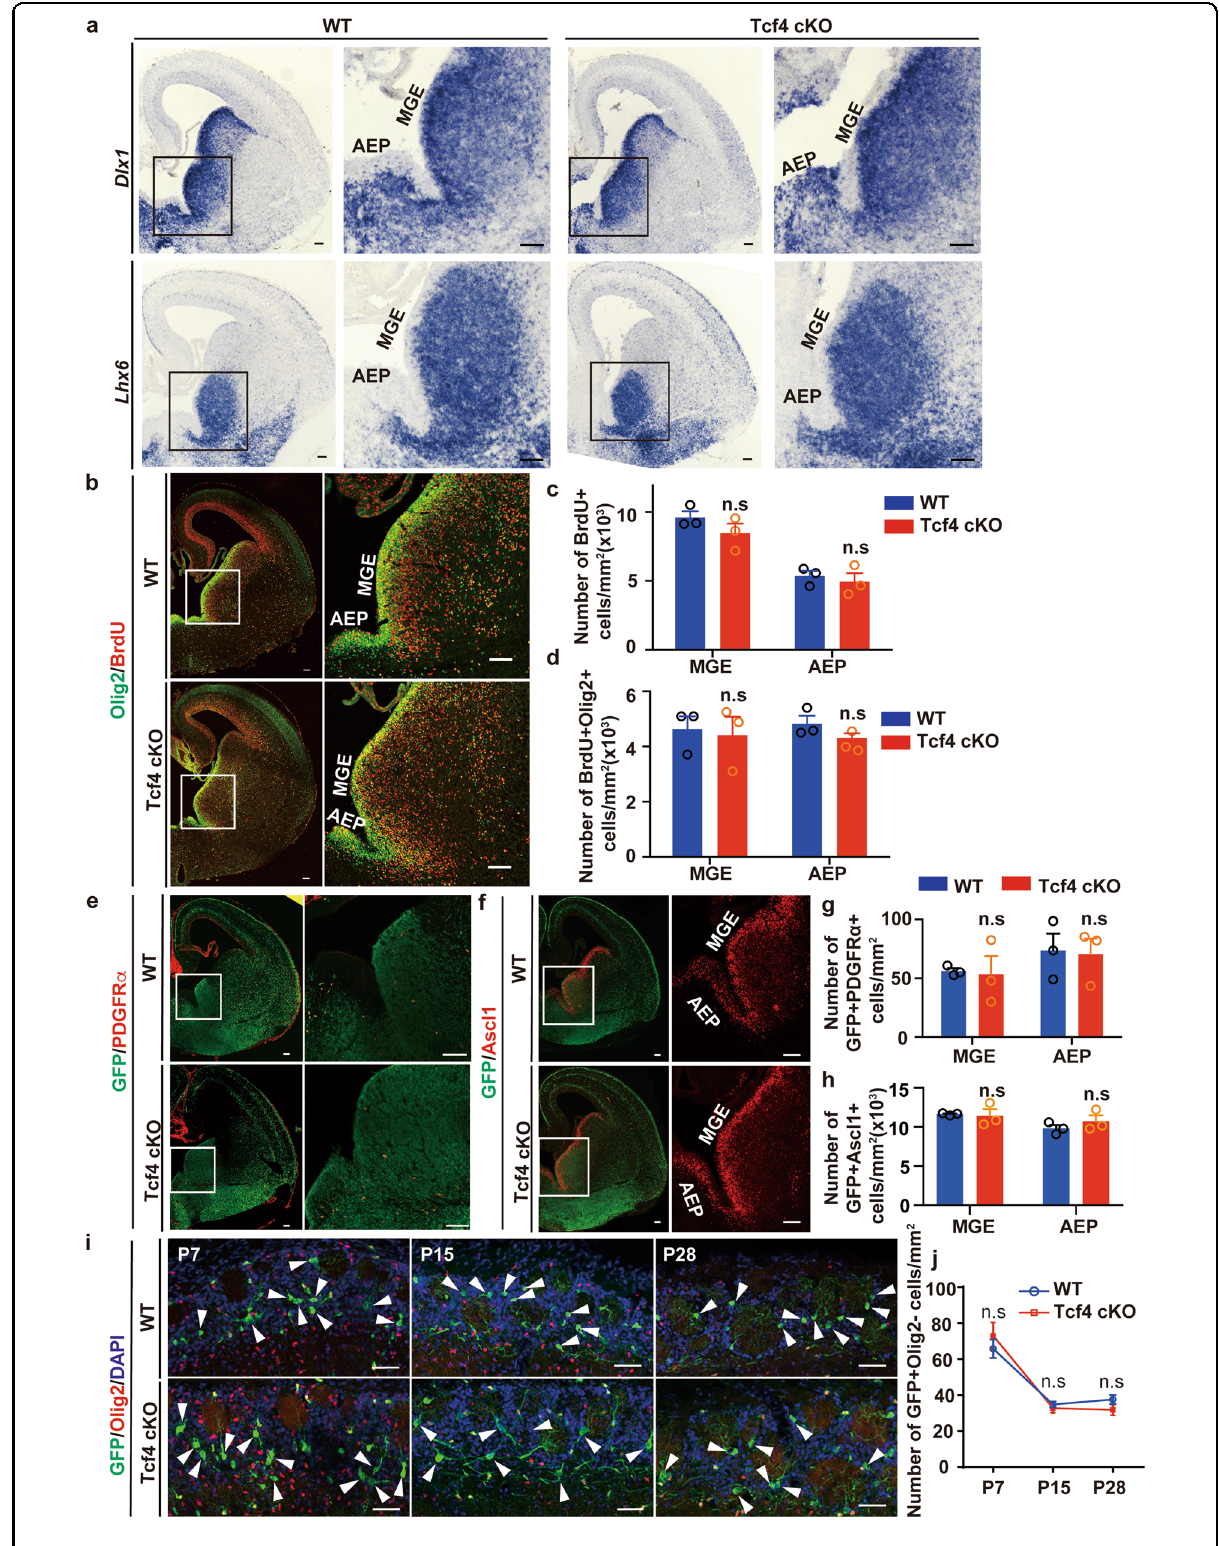
Fig. 3 (See legend on next